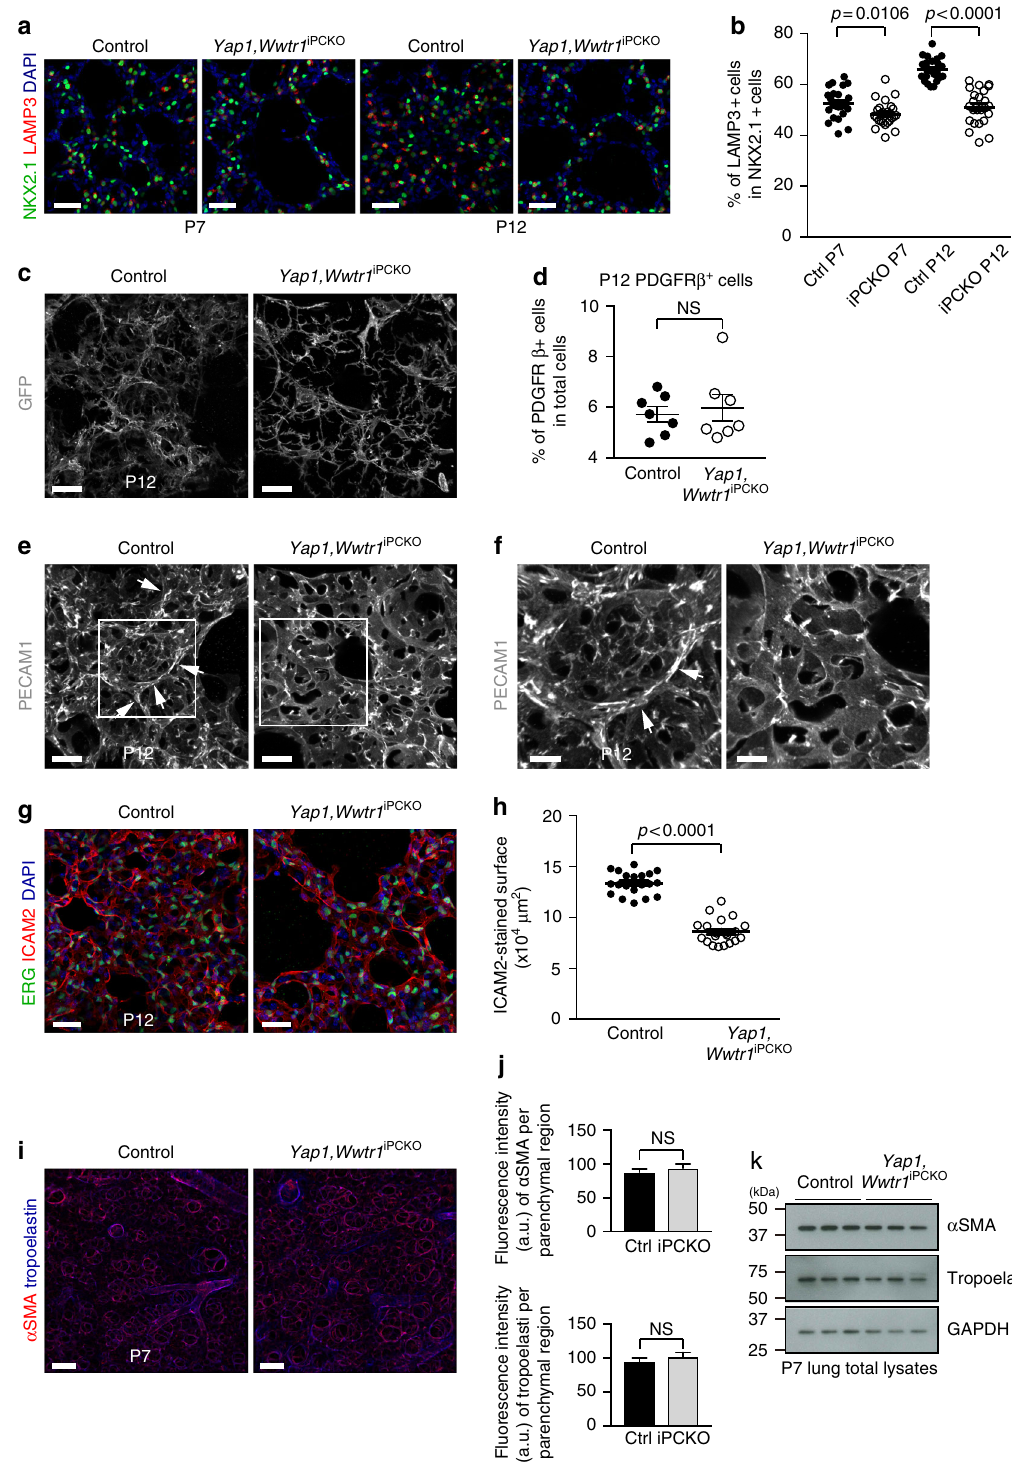
Pericyte-derived Angpt1 regulates alveologenesis . In addition to HGF/c-Met signalling, angiopoietin-1 (Angpt1), one of the growth factors that is highly expressed by pulmonary pericytes (Fig. 4d), and the corresponding receptor Tie2/Tek, which is expressed by ECs (Fig. 5a), are involved in lung morphogenesis 28 . Expression of Angpt1 by PDGFR β + pulmonary pericytes is also con fi rmed with Angpt1 GFP knock-in reporter mice (Fig. 5b). Whereas levels of Angpt1 are dramatically reduced in Yap1